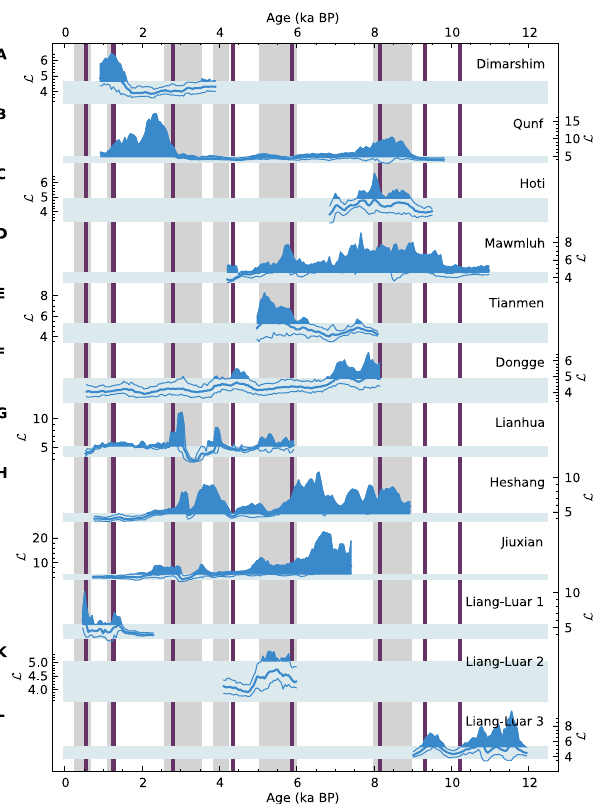
Figure A3. Time evolution of the regularity (RN transitivity T ) of variations in monsoonal strength obtained as in Fig. A2 (colour coding is analogous to Fig. A2 after replacing blue shading with green). Here, deviations from the predominant dynamical regime indicate epochs of significantly enhanced or diminished regularity of monsoonal variability (filled-in dark green